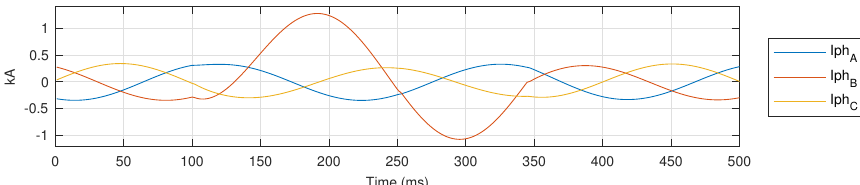
Figure 9. Iph ABC for a bolted LG fault on phase B in AUTO mode.